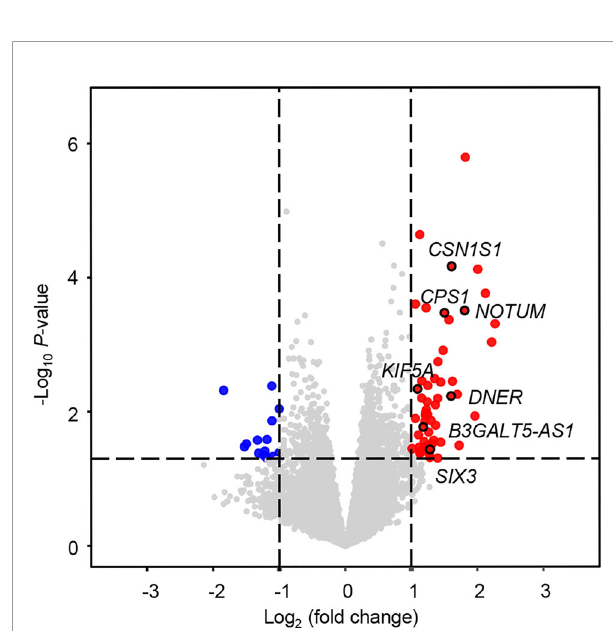
FIGURE 2 | Volcano plot for differentially expressed mRNAs between patients with and without distant metastasis. In total, 71 differentially expressed mRNAs were screened out with log 2 (fold change) > 1 or < -1 and P < 0.05. Signi fi cantly upregulated and downregulated mRNAs are shown as red and blue dots, respectively.